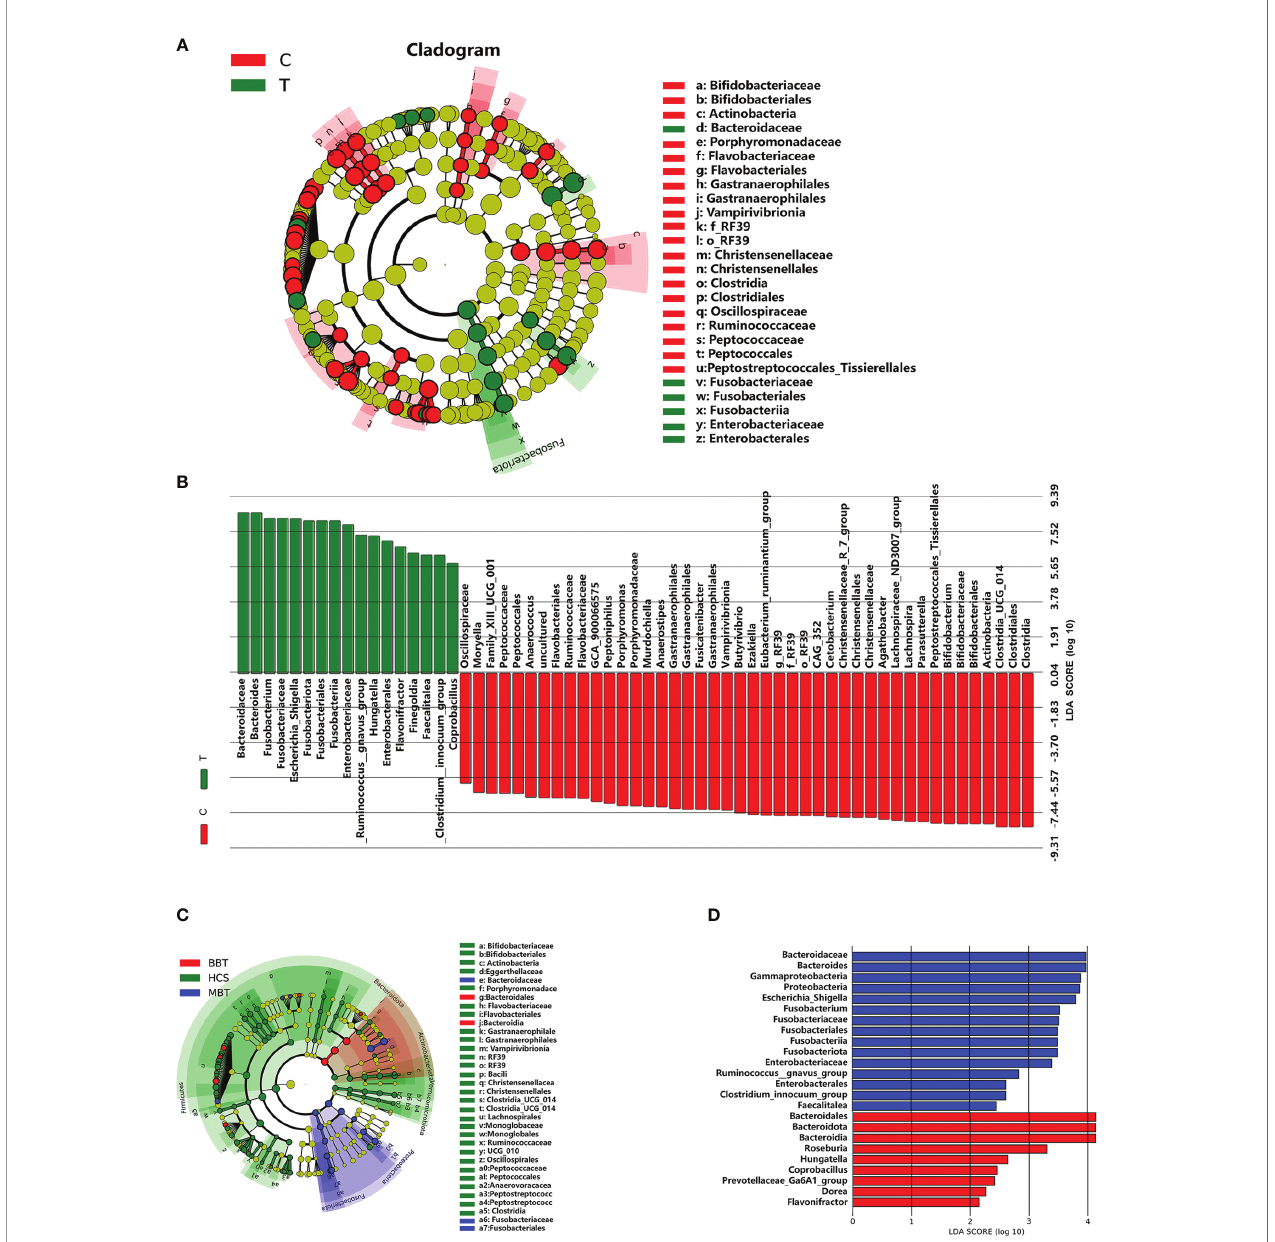
FIGURE 3 | Differential enriched bacterial taxa between different groups. Linear discriminant analysis (LDA) integrated with effect size (LEfSe) was used to identify the taxa with the greatest differences in abundance between different groups. Cladogram indicating the phylogenetic distribution of microbiota correlated with the T or C groups (A) . Histogram of the LDA scores computed for differentially abundant taxa between T and C groups (B) . Meanwhile, the enriched taxa in the malignant brain tumours, benign brain tumours and the healthy were also displayed in the cladogram (C) , and the differences in abundance between the malignant and benign brain tumours (D) . The central point represents the root of the tree (microorganism), and each ring represents the next lower taxonomic level. The diameter of each circle represents the relative abundance of the taxon, only the taxa satis fi ed an obvious LDA threshold value of >2 are